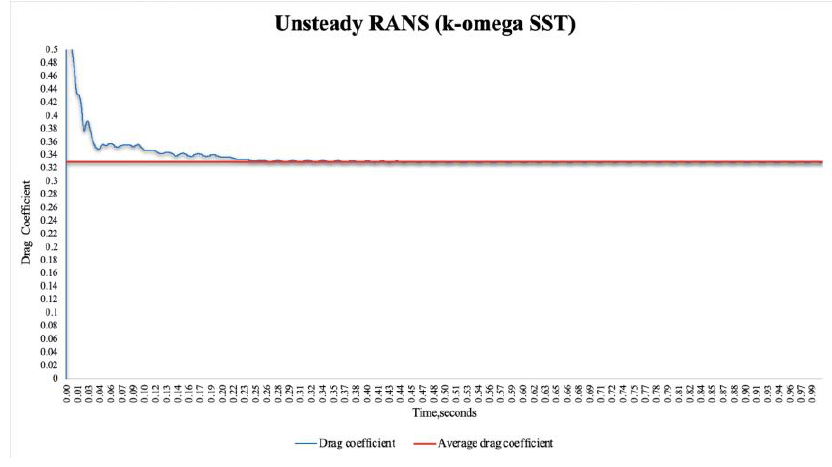
Figure 15. Drag as a function of time predicted by URANS.